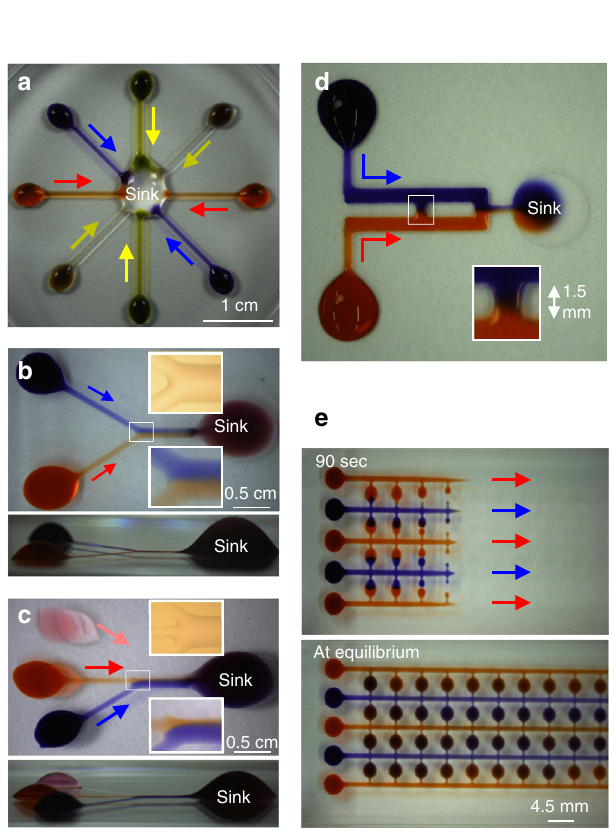
Fig. 3 Some FF circuits carrying out different functions. Colored dyes were pipetted manually into input drops, and they are fl owing ( colored arrows ) to sink drops autonomously. Insets illustrate how accurately pinning lines are built. a Mixing 8 fl uids. b Generating a stable concentration gradient across two laminar streams after the junction ( side view below ). c Flow focusing